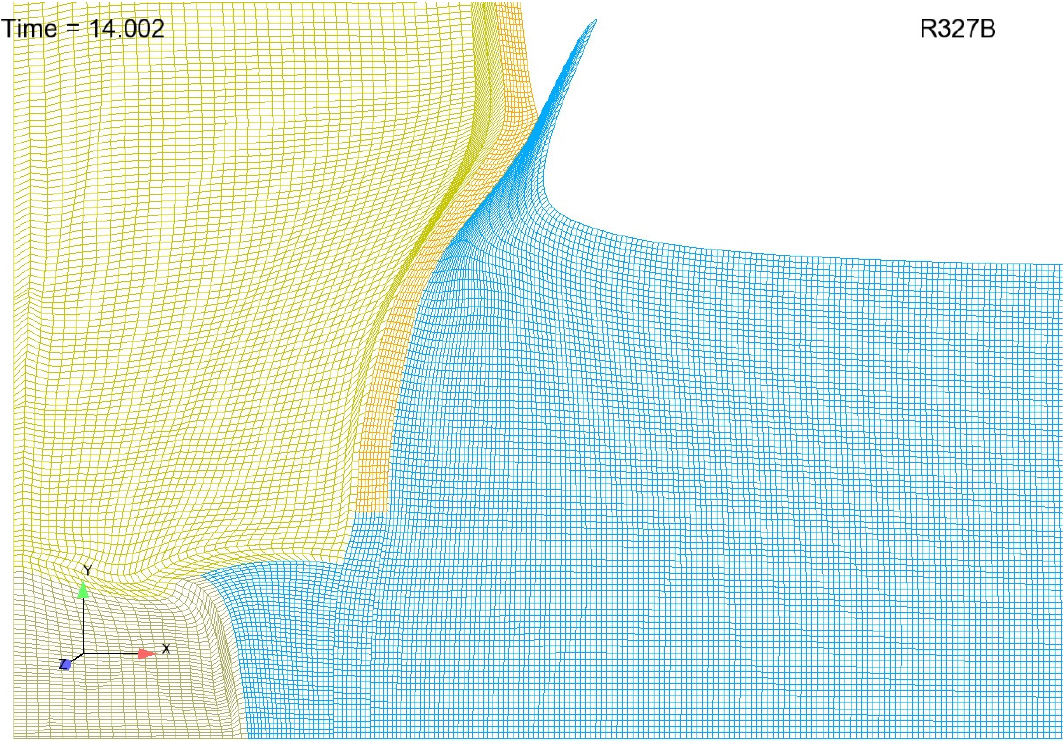
Figure 4. Jet morphology resultant from initially uniform mesh.